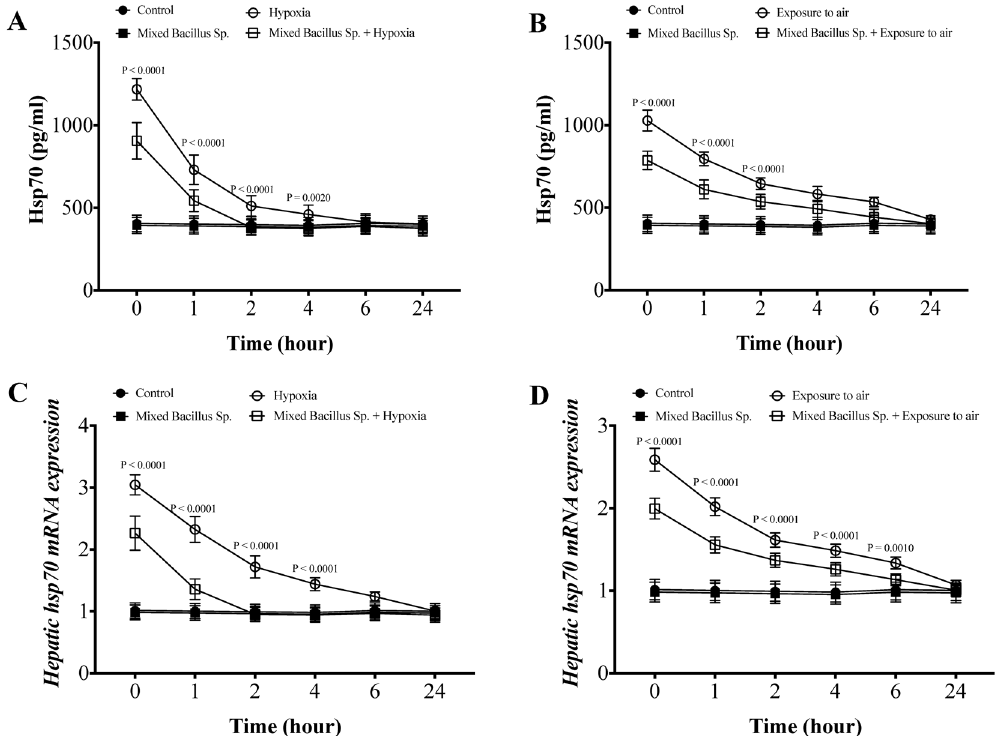
Figure 5. A mixed Bacillus Species decreases the expression of heat shock protein (Hsp70). Yellow Perch response to hypoxia and air exposure stress over 24 h as reflected in ( A , B ) plasma Hsp70 levels and hepatic hsp70 mRNA expression that were quantified using ELISA and RT-qPCR. Sample size = 9/group. Two-way Repeated measure ANOVA followed by comparing mixed Bacillus spp + stressed group to stressed groups was applied at two-tail significance level (P < 0.05). Data represented in mean ±